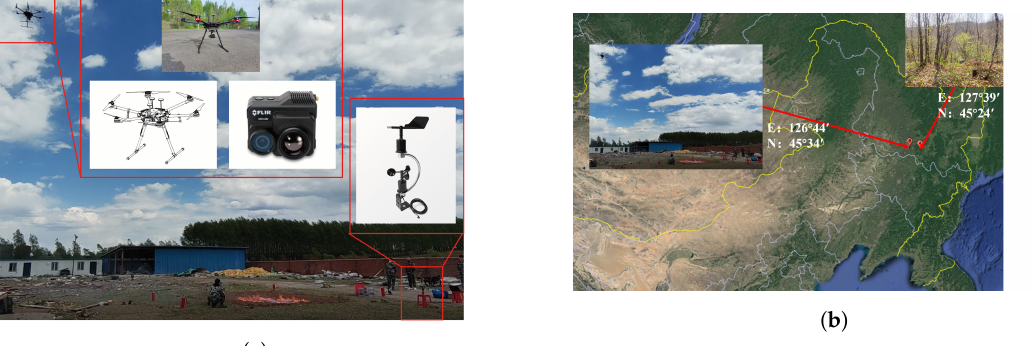
Figure 1. The experiment area: ( a ) Burning experiment configuration. ( b ) The locations of experiment and fuel collection.